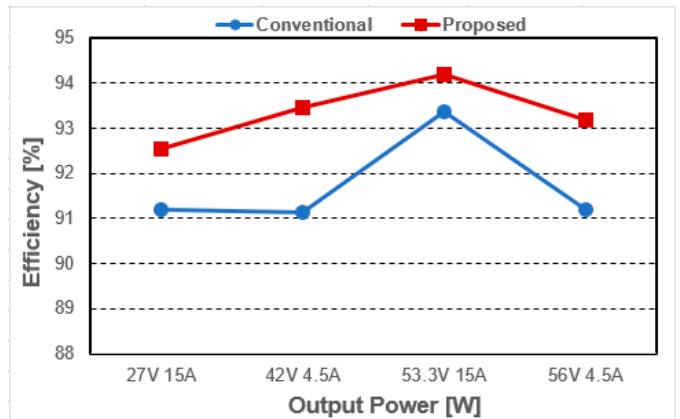
Figure 10. Simulation efficiency.